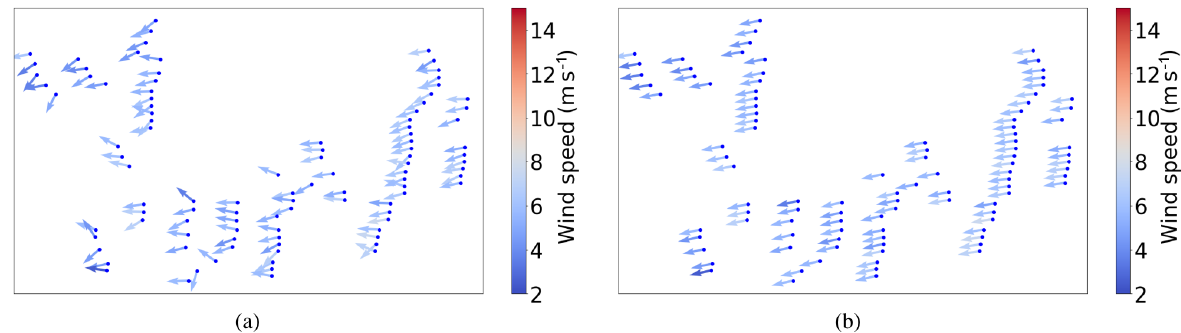
Figure 7. (a) The wind direction recorded at each turbine across the wind farm at one time step using actual SCADA data recorded at each turbine. (b) The wind direction estimated by the consensus algorithm at the same time step.